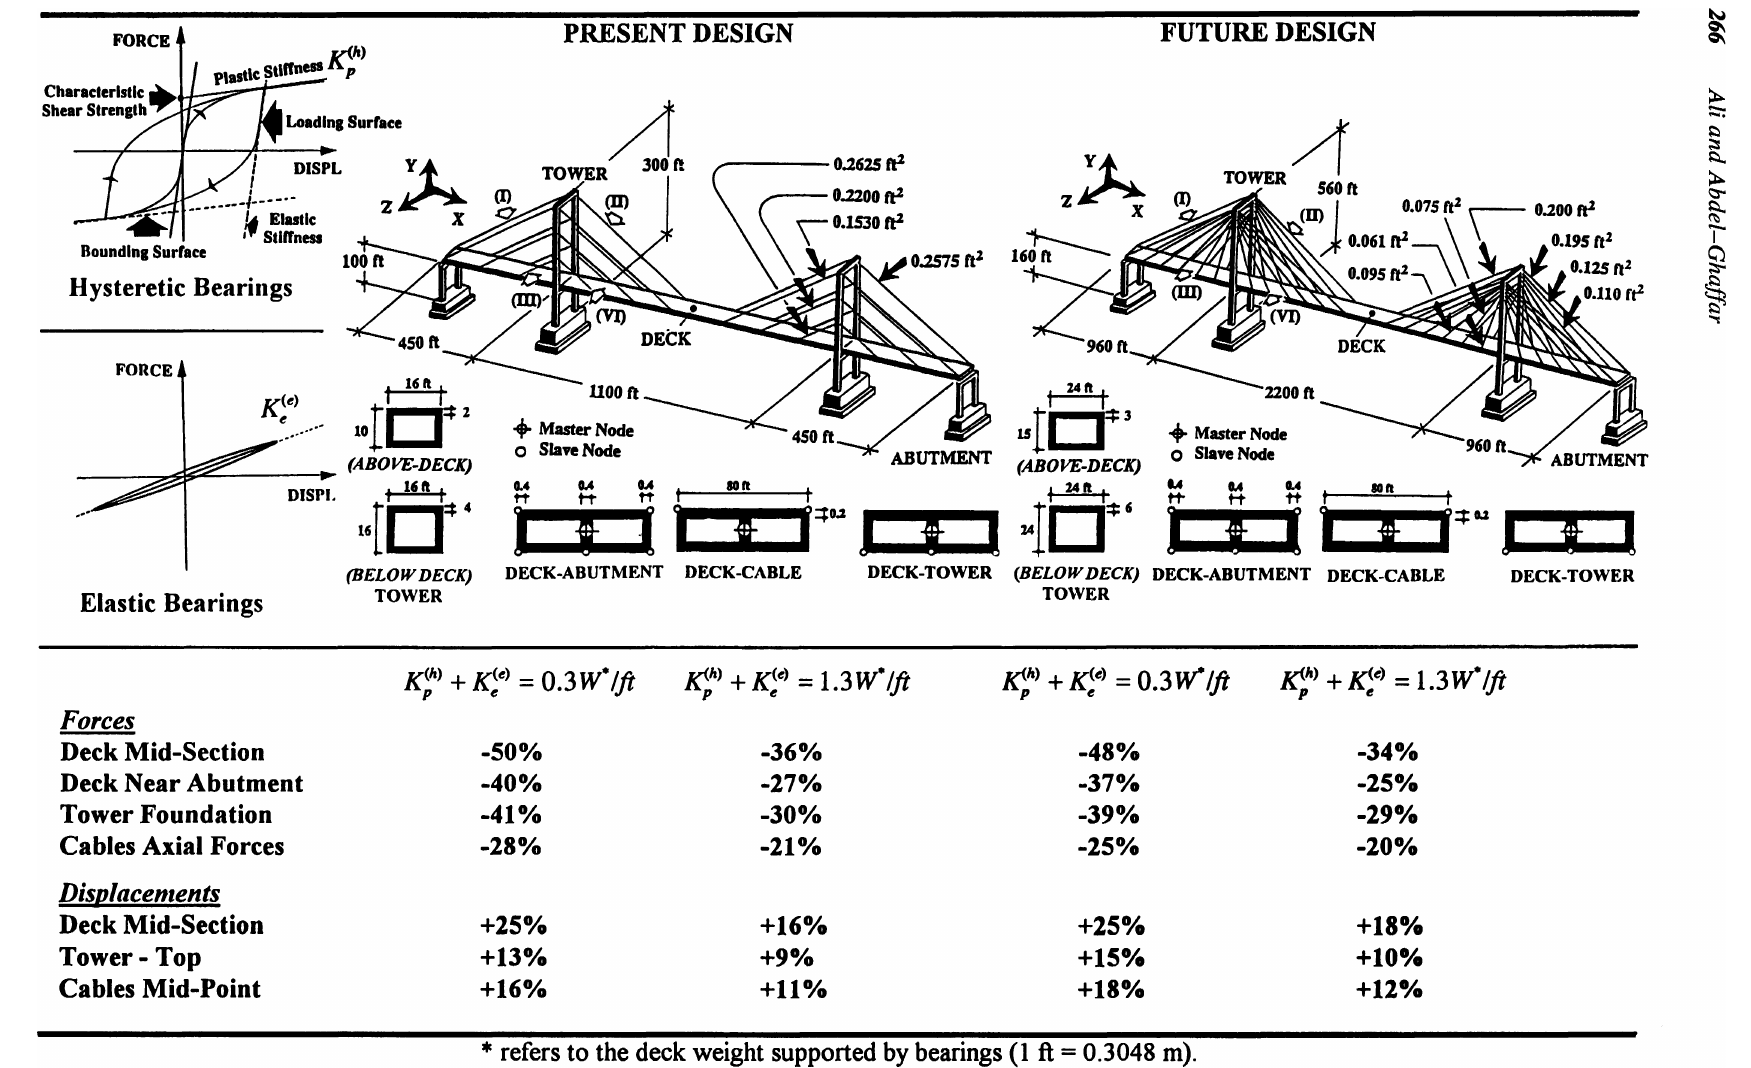
FIGURE 3 Energy dissipation for present and future bridge designs. The positive and negative signs refer to the increase and decrease percentages, respectively, in the response value as compared to the bridge without